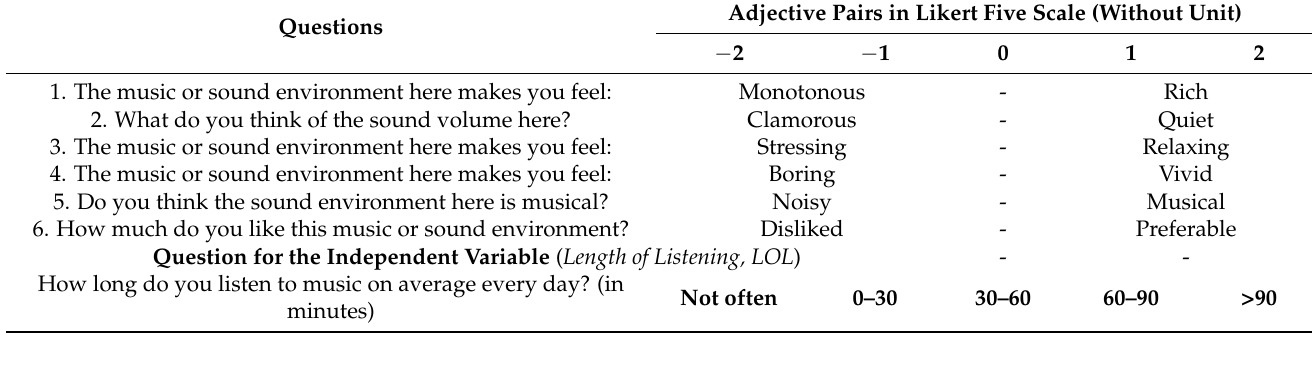
Table 1. Subjective Soundscape Experience Evaluation Questions and Adjective Pairs.